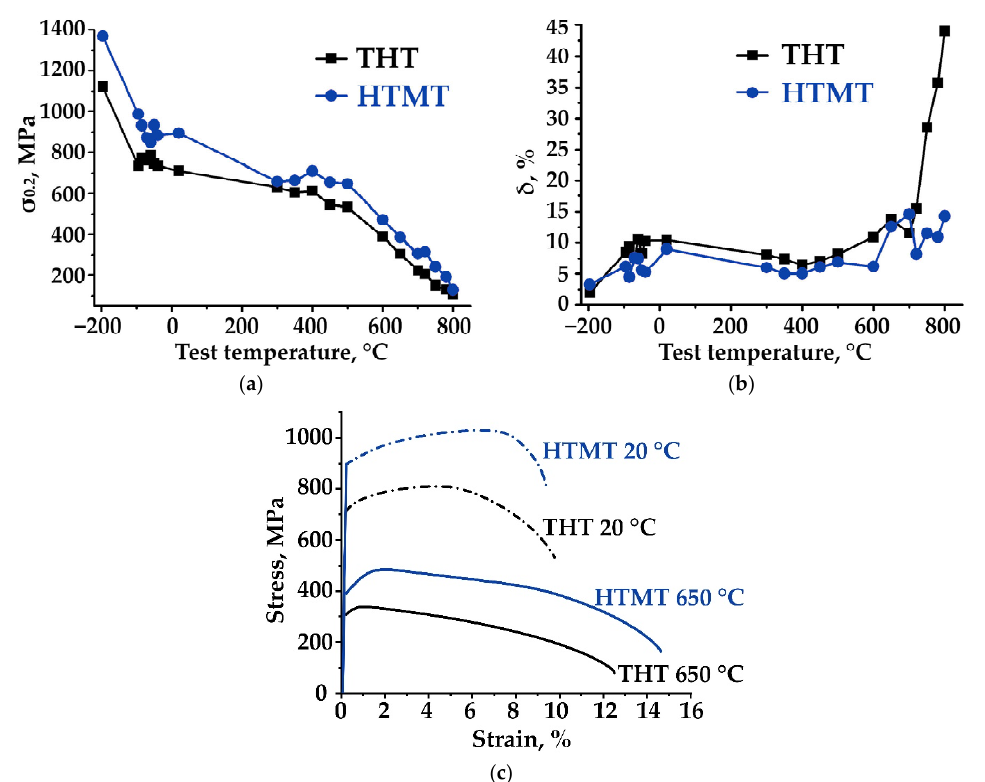
Figure 9. Tensile properties of EK-181 steel after THT and HTMT: curves of temperature dependence of yield strength ( a ) and relative elongation to failure ( b ), engineering stress-strain curves of samples tested at 20 and 650 °C ( c ).